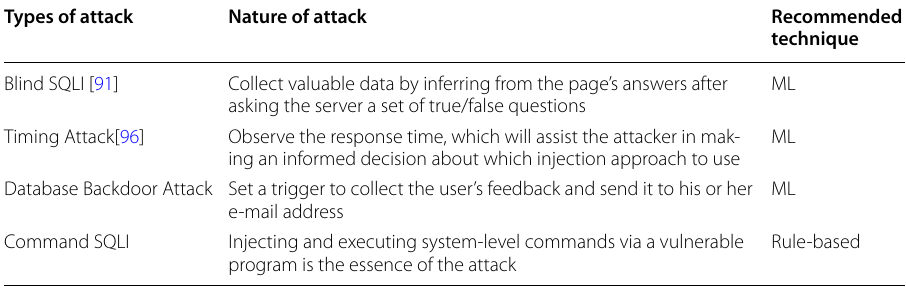
Different forms of attack under inference query are shown in Table 6. Table 6 Common inference query attack [54] Types of attack Nature of attack Recommended